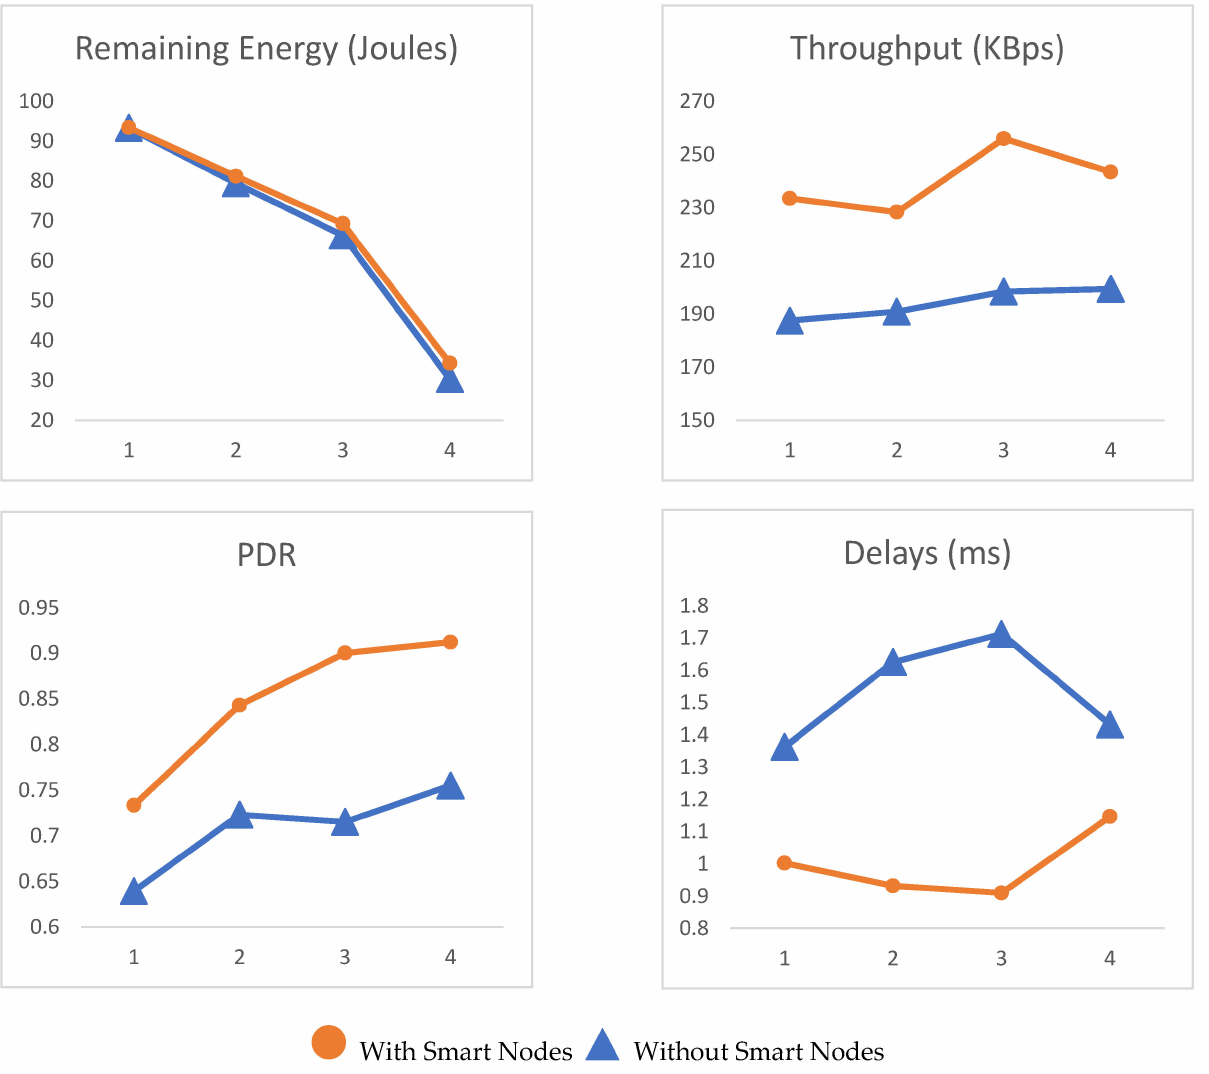
Figure 14. Case scenario 3: Proactive nodes are deployed in an L